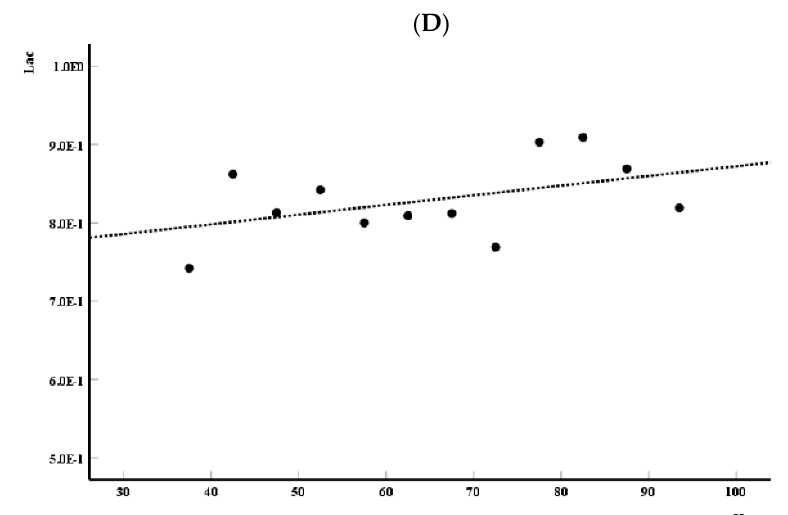
Figure 2. ( A – D ): Distribution of four image properties ( D bin , D out , D skel and Lac) with age.